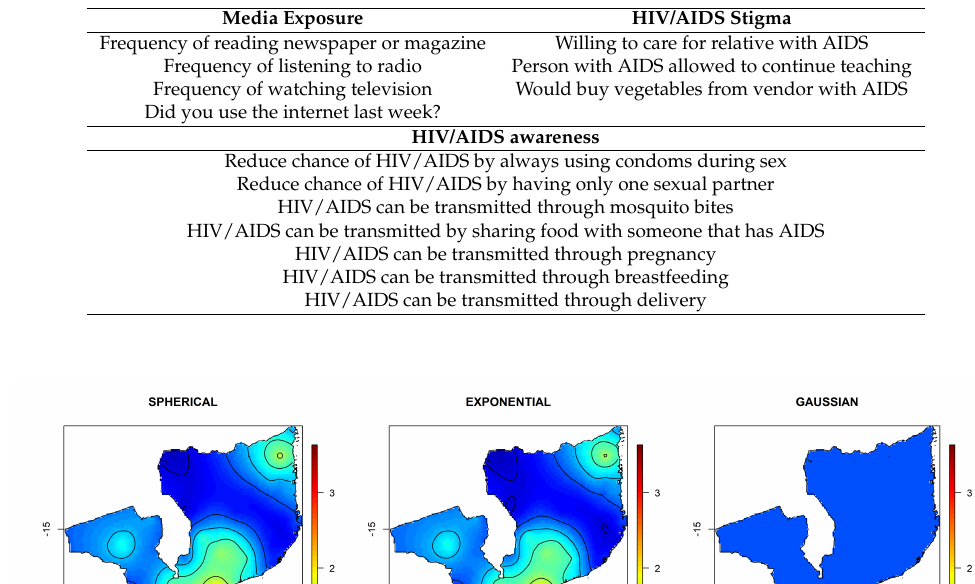
Table A2. Questionnaire items used to derive media exposure index, HIV/AIDS awareness index, and HIV/AIDS stigma index.